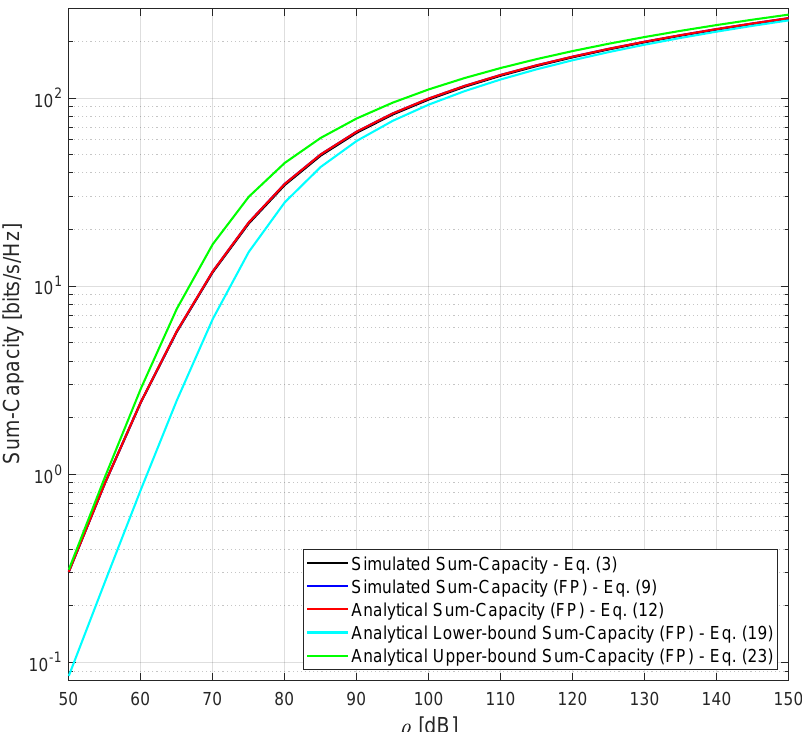
Figure 3. Simulated and analytical sum-capacity considering M = 300.